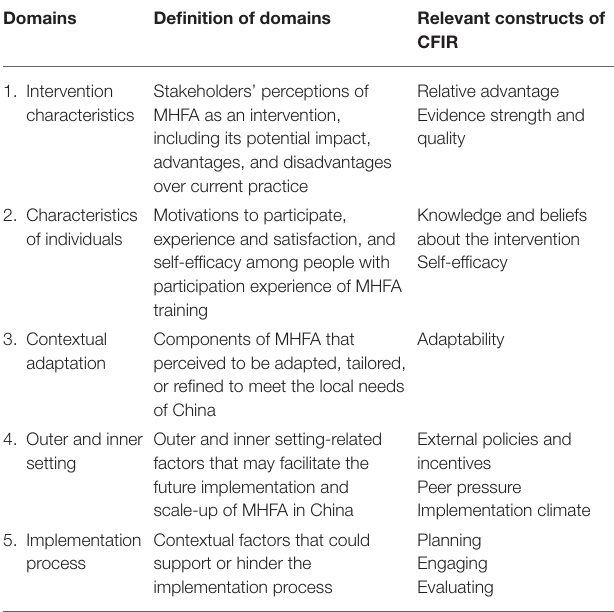
TABLE 2 | Selected implementation domains, definitions, and constructs of the Consolidated Framework for Implementation Research (CFIR) used in the study.